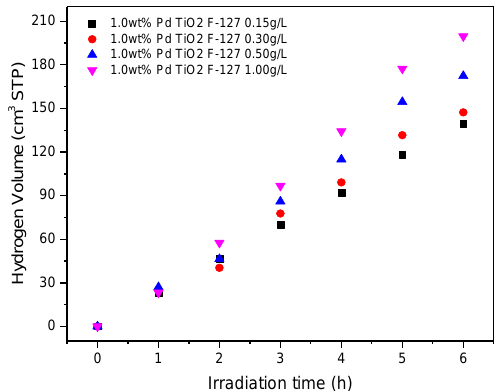
Figure 7. Cumulative hydrogen production using 1.0 wt% Pd–TiO 2 at different catalyst concentrations (0.15, 0.30, 0.50 and 1.0 g/L). Conditions: 2.0 v/v% ethanol, pH = 4 ± 0.05 and near-UV light. Standard deviation: ± 4.0%.